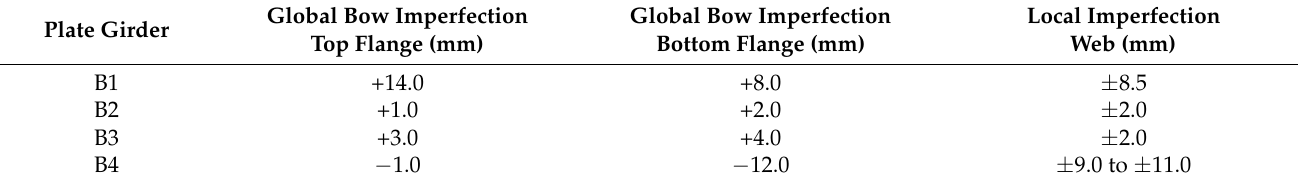
Table 1. Geometric imperfection amplitudes (+/ − indicates the direction of the imperfection). Plate Girder